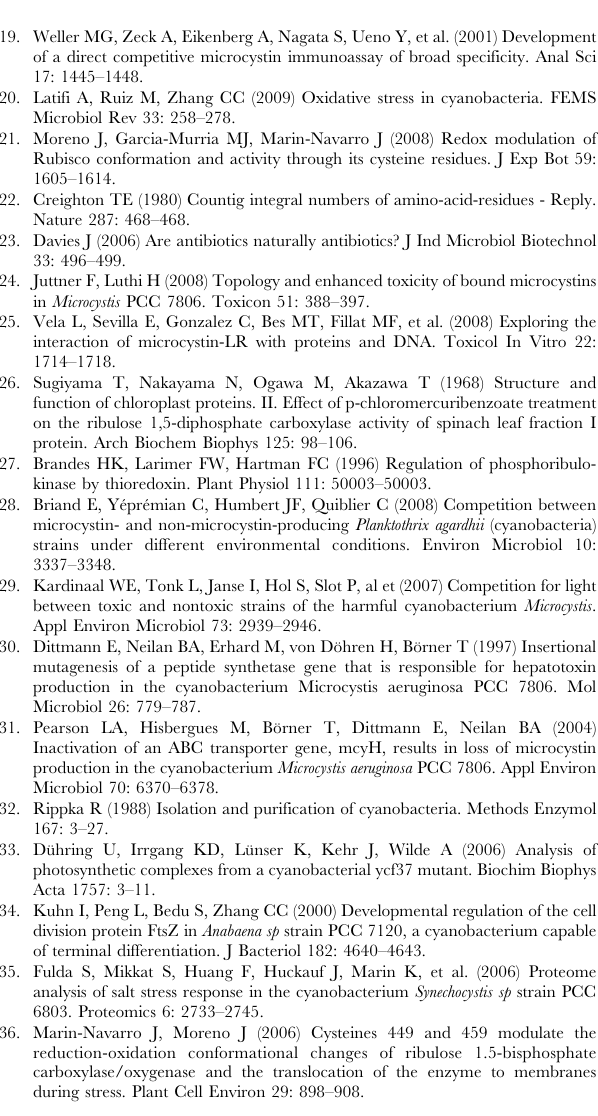
Figure S2 Microcystin-binding in carboxysome-enriched frac- tion that was obtained by fractionated solubilization. A) Coomassie stained fractions of wild type and D mcyB mutant. B) Immunoblot analysis using anti-RbcL antibody (identity of RbcL was further confirmed using mass spectrometry). C) Immunoblot analysis using anti-microcystin antibody. Figure S3 Differential alkylation pattern of RbcL of PCC 7806 wild type and D mcyB mutant, respectively, with iodoacetamide and iodoacetate leading to charge differences depending on the presence of free thiol groups. RbcL fractions were run on native PAGE and subsequently evaluated by immunoblot analysis with an RbcL specific antibody. Figure S4 Recovery of D mcyB mutant and wild type after one week irradiation with 300 m mol photons m 2 2 s 2 1 and